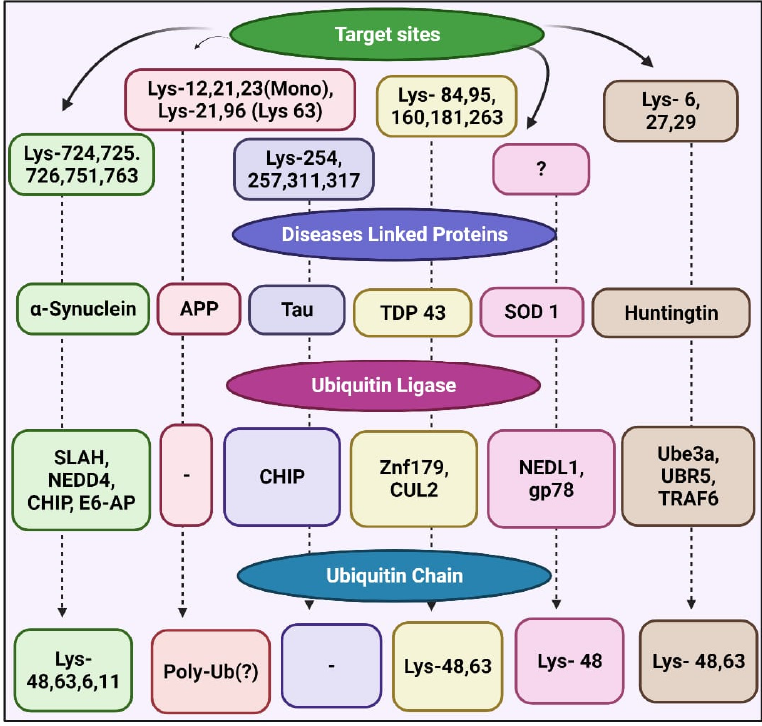
Figure 3. Ubiquitination of neurodegenerative-disease-associated proteins and various target sites [48] .